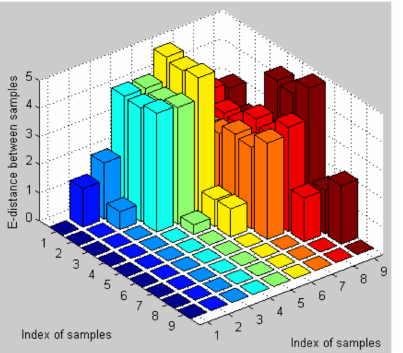
Figure 10. Larger interdistances and smaller intradistances among hand